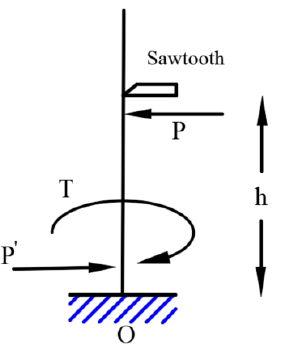
Figure 12. Schematic diagram of the forces on the branch sawing.